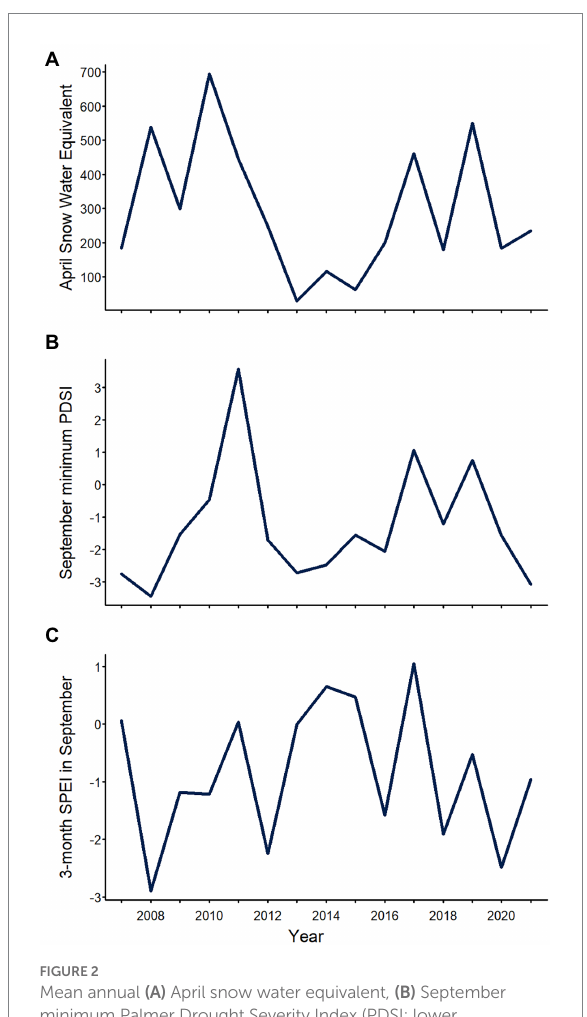
FIGURE 2 Mean annual (A) April snow water equivalent, (B) September minimum Palmer Drought Severity Index (PDSI; lower values = drier conditions), and (C) 3-month Standardized Precipitation Evapotranspiration Index (SPEI) in September in Yosemite National Park, California, United States, 2007–2021, averaged across surveyed sites.